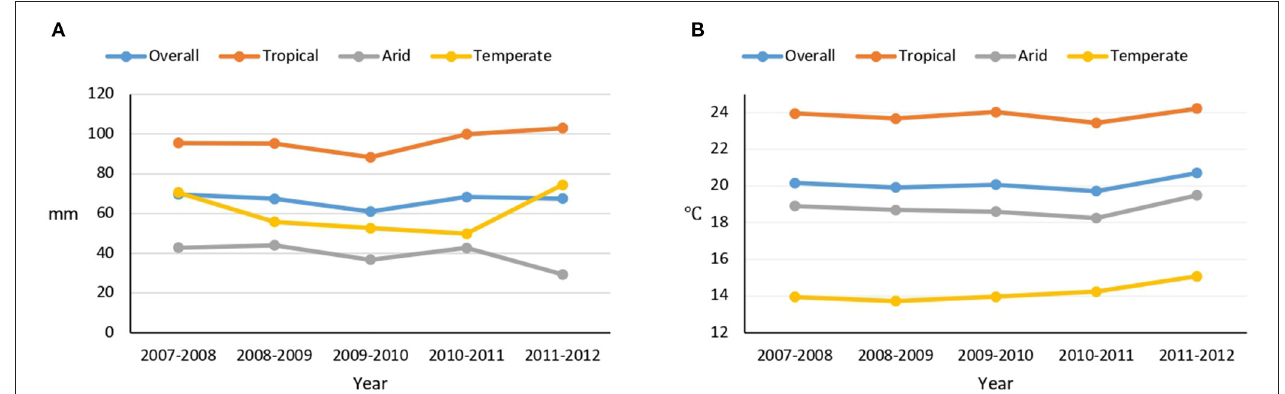
FIGURE 1 | Mean annual rainfall (A) and temperature (B) in Mexican cities over the 5 years prior to the 2012 Mexican National Health and Nutrition Survey (2007–2008 to